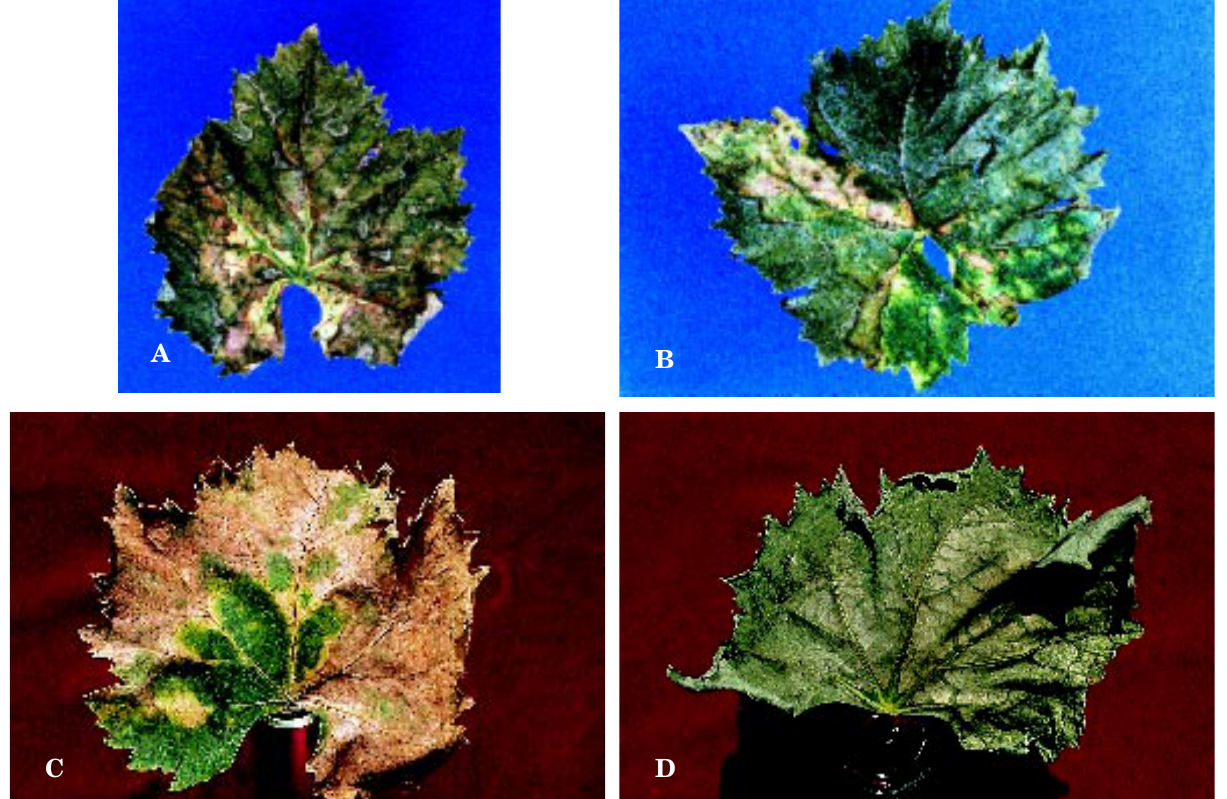
Fig. 1. Effect of the absorption for a few hours of 3 ml each of: A. 0.02 mg ml -1 EPS from culture filtrate of 28-day-old P. chlamydosporum liquid culture; B. 0.05 mg ml -1 pullulan purified from EPS; C. 0.05 mg ml -1 pullulan purified from 30-year-old esca-affected ‘Sangiovese’ grapevine; D. 0.02 mg ml -1 Sigma pullulan on detached leaves of grape- vine cv. Italia.